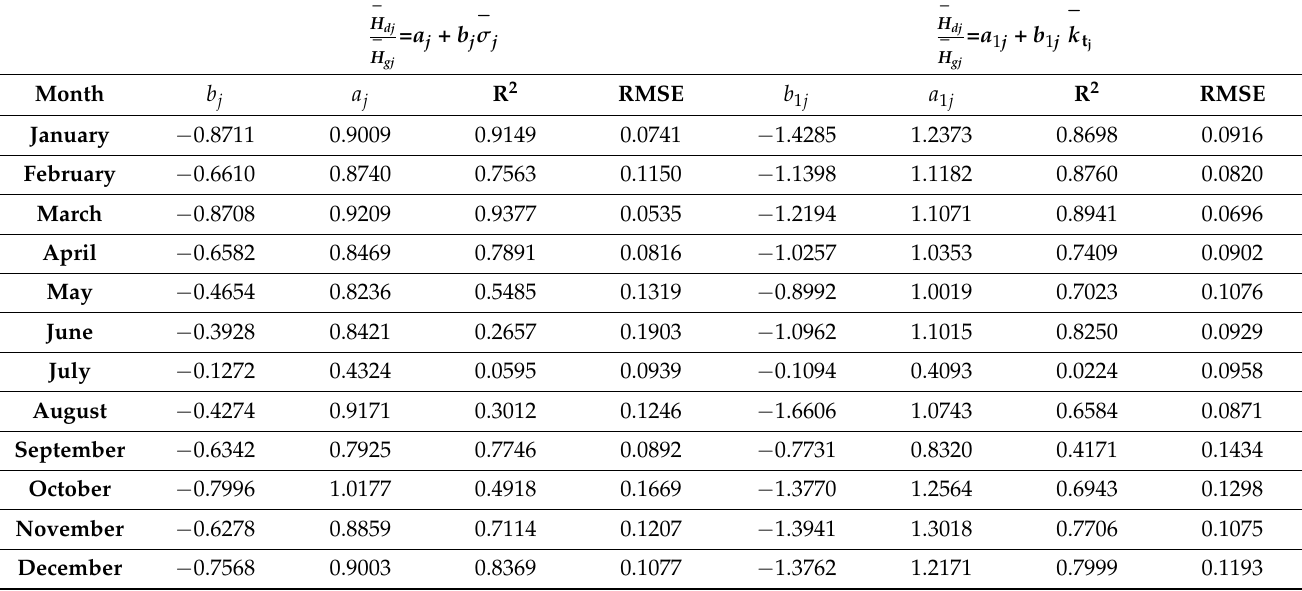
Table 1. Regression coefficients of the fit by the relation 1 and 2: